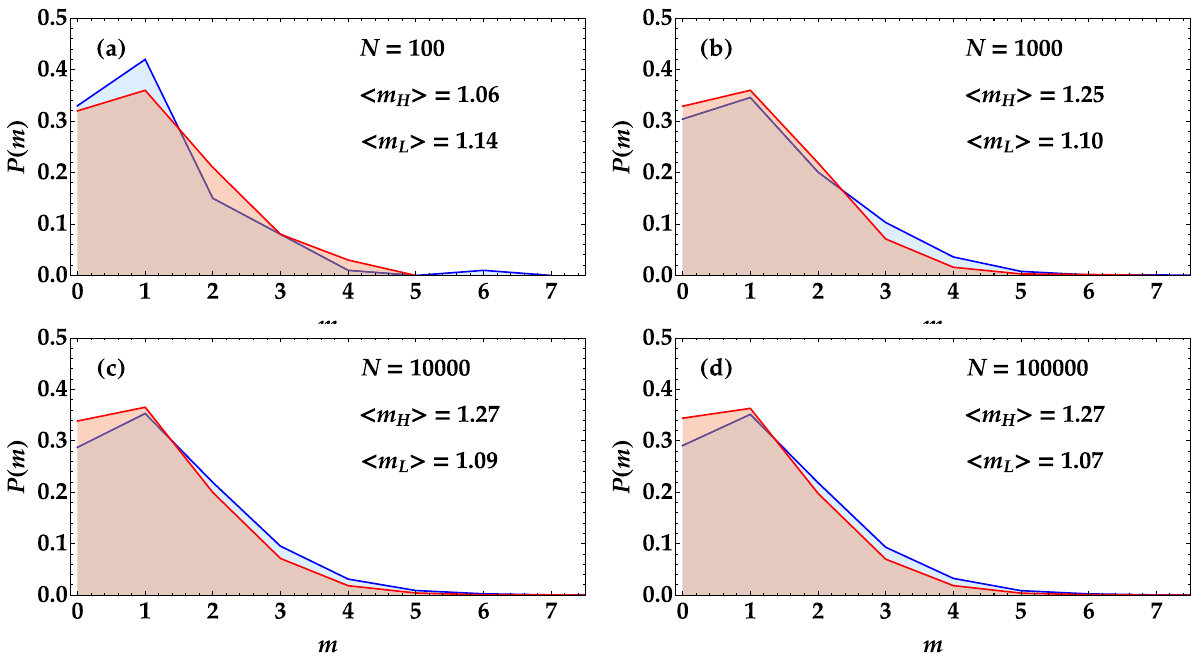
Figure 2. Experimental reconstruction of the distribution of detected photons when a single-mode thermal state is superimposed to a portion of TWB. The blue curves correspond to the state with the higher mean value, whereas the red curve to the lower mean value. The different panels correspond to different number of shots used to reconstruct such